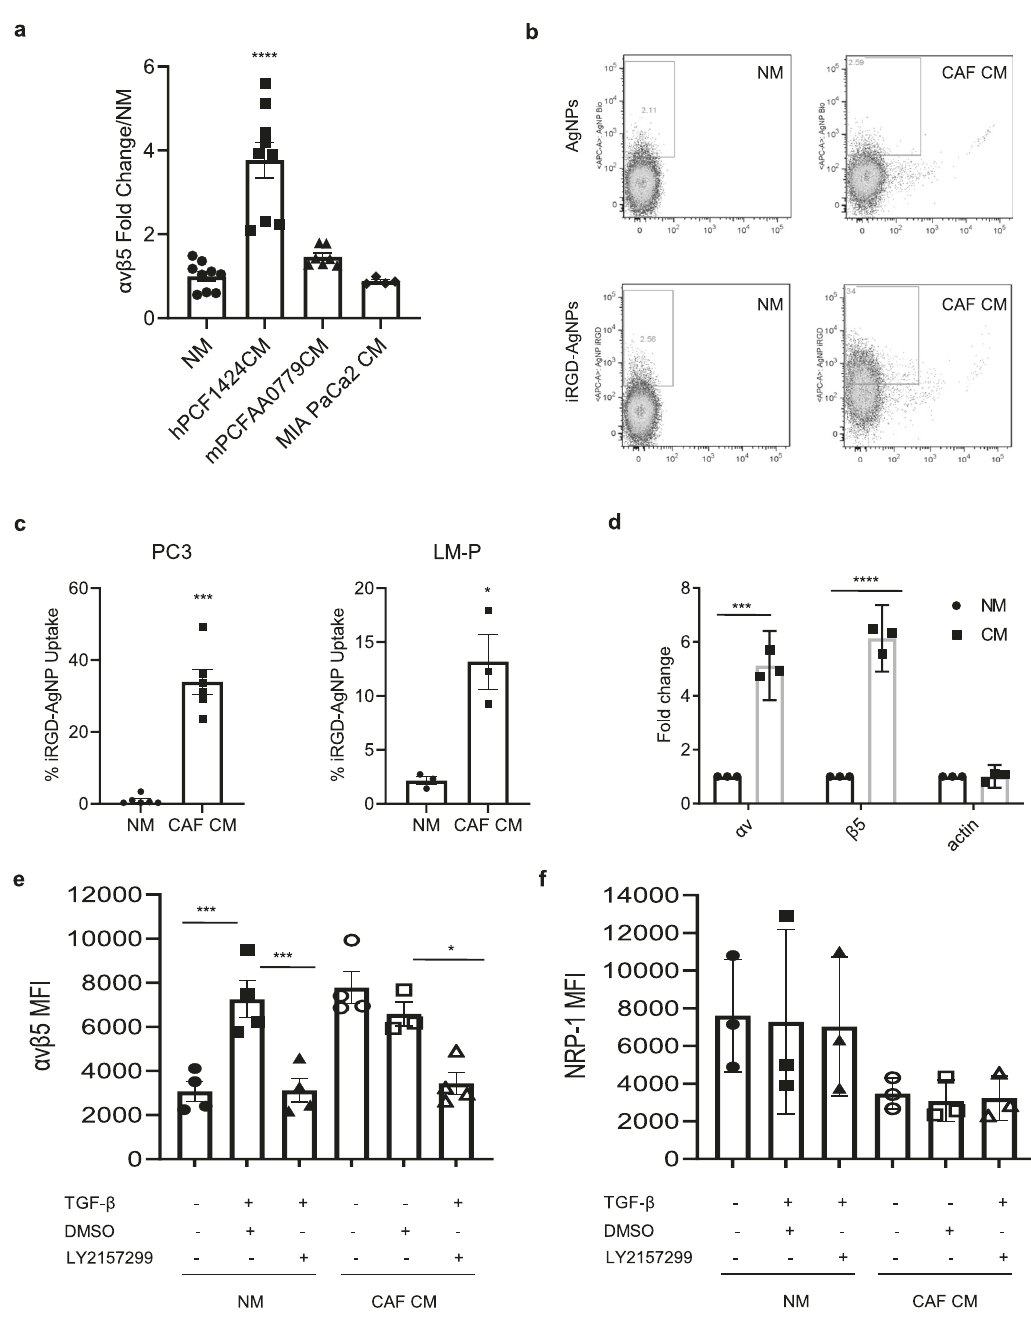
Fig. 4 CAF conditioned media (CM) enhances α v β 5 expression in tumor cells. a Expression of α v β 5 integrin in PC3 cells after 2 days of incubation in normal media (NM) or CM prepared from cultured hPCF1424 CAFs ( n = 9), mPCFAA0779 CAFs ( n = 7), or MIA PaCa-2 human PDAC cells ( n = 4) performed in independent experiments. Fold over NM is shown. One-way ANOVA; p < 0.0001 (NM vs. hPCF1424 CM), p = 0.5085 (NM vs. mPCFAA0779 CM), p = 0.9886 (NM vs. MIA PaCa-2). b Dot plots representing iRGD-AgNP or control AgNP uptake in PC3 cells cultured in NM or CM from hPCF1424 CAFs. c The bar diagrams show the proportion of PC3 (left) or LM-PmC (right) cells that internalized iRGD-AgNPs. The cells were incubated in NM or CM from hPCF1424 CAFs for 2 days prior to study. n = 6 (PC3), n = 3 (LM-P) independent experiments. Two-tailed unpaired Student ’ s t test; p = 0.0001 (PC3 NM vs. CAF CM), p = 0.0127 (LM-P NM vs. CAF CM). d Expression of actin, α v, and β 5 integrin mRNAs normalized against cyclophilin A analyzed by qPCR in PC3 cells incubated with NM or CM from hPCF1424 CAFs. n = 3 independent experiments. Two-tailed unpaired Student ’ s t test; p = 0.00016 ( α v), p < 0.0001 ( β 5), p = 0.923 (actin). e , f Expression of α v β 5 integrin ( e ) or NRP-1 ( f ) in PC3 cells cultured in normal media (NM) or CM from hPCF1424 CAFs in the presence or absence of exogenous TGF- β , a TGF- β -speci fi c inhibitor LY2157299, or vehicle alone. Mean fl uorescence intensity (MFI) assessed by fl ow cytometry is shown. n = 4 independent experiments. Two-tailed unpaired Student ’ s t test; p = 0.0008 ( e: NM vs. TGF- β ), p = 0.0009 ( e: TGF- β vs. TGF- β + LY2157299), p = 0.7082 ( e: CAF CM vs. CAF CM + DMSO), p = 0.0177 ( e: CAF CM + DMSO vs. CAF CM + LY2157299). No signi fi cant differences in ( f ). All error bars, SEM; * p < 0.05; ** p < 0.01; *** p < 0.001; **** p < 0.0001. Source data provided in Source Data fi le.